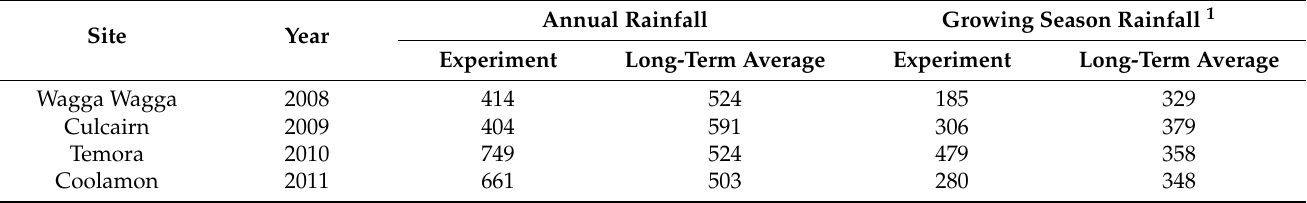
Table 1. Annual and growing season rainfall (mm) at experimental sites compared to the long-term average for each respective site. Annual Rainfall Growing Season Rainfall Site Year